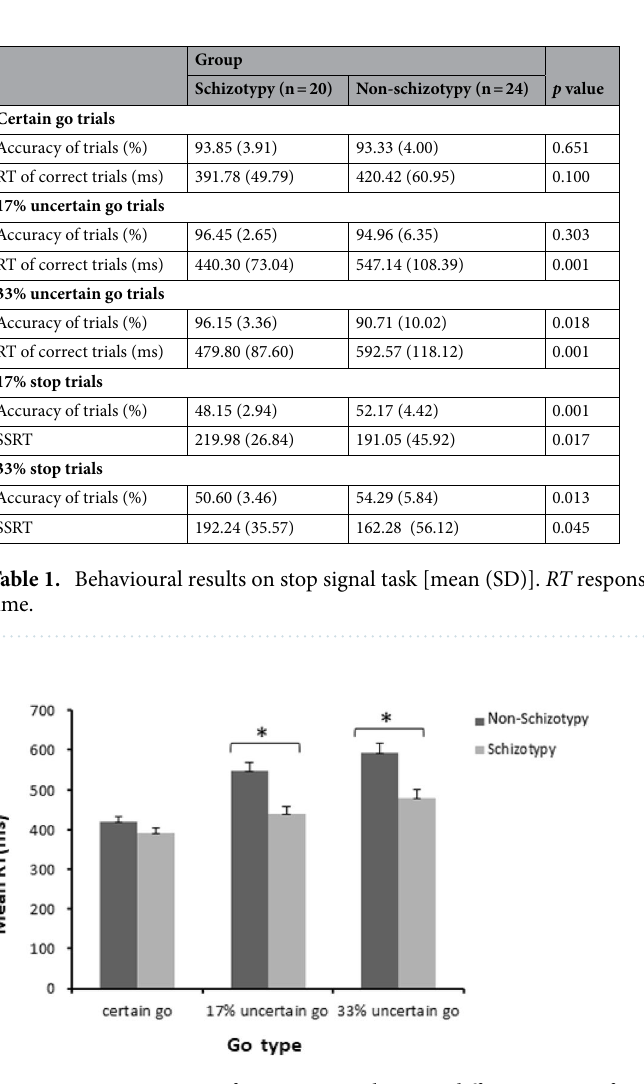
Figure 1. Response time of correct Go trials across different Go type for the non-schizotypy and schizotypy group. *Significant ( p < 0.05) group differences in post hoc analyses. Error bars represent standard